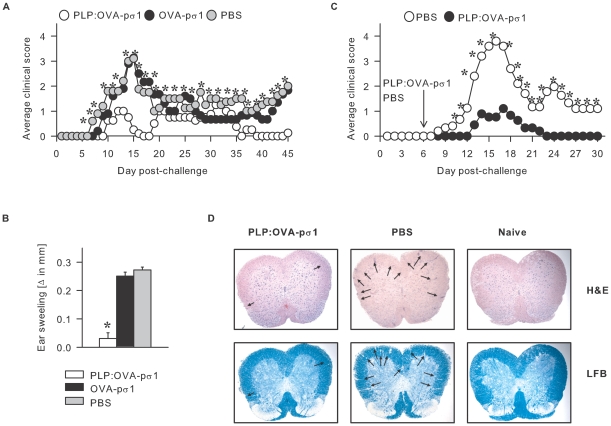
Nasal administration of PLP:OVA-pσ1 protects mice from EAE.
A. Mice were dosed with 100 µg of PLP:OVA-pσ1, OVA-pσ1, or PBS on days −21, −14, and −7, challenged with PLP139–151 peptide on day 0, and monitored daily for the development of clinical disease. PBS and OVA-pσ1-dosed mice developed fully pronounced EAE and never recovered completely. PLP:OVA-pσ1-immunization prior to EAE induction significantly delayed and ameliorated clinical onset of EAE and resulted in a complete recovery of all PLP:OVA-pσ1-dosed mice. Average of 10–15 mice per group is shown. * P<0.05 for PLP:OVA-pσ1 vs. PBS. B. Anti-PLP139–151 DTH response measured two weeks after EAE induction confirmed that, unlike in PBS- or OVA-pσ1-dosed mice, PLP139–151-specific Th1 response was diminished in PLP:OVA-pσ1-dosed mice. Mean + SD of 10–15 mice per group is depicted. * P<0.001 for PLP:OVA-pσ1 vs. PBS. C. Mice were dosed with a single 100 µg dose of PLP:OVA-pσ1 or PBS on day +6 relative to the day of EAE induction. Unlike PBS, single dose administration of PLP:OVA-pσ1 significantly inhibited the occurrence and duration of the clinical EAE. * P<0.05 for PLP:OVA-pσ1 vs. PBS. D. Mice dosed with PLP:OVA-pσ1 or with PBS 21 days before EAE induction were sacrificed at the peak of the disease (day 14 post-challenge), and histopathology of their spinal cords was determined by staining with luxol fast blue (LFB) and H&E. Mice dosed with PLP:OVA-pσ1 showed significant reduction in the central nervous system (CNS) tissue pathology (designated by arrows) compared to PBS-dosed mice. * P<0.001 for PLP:OVA-pσ1 vs. PBS.